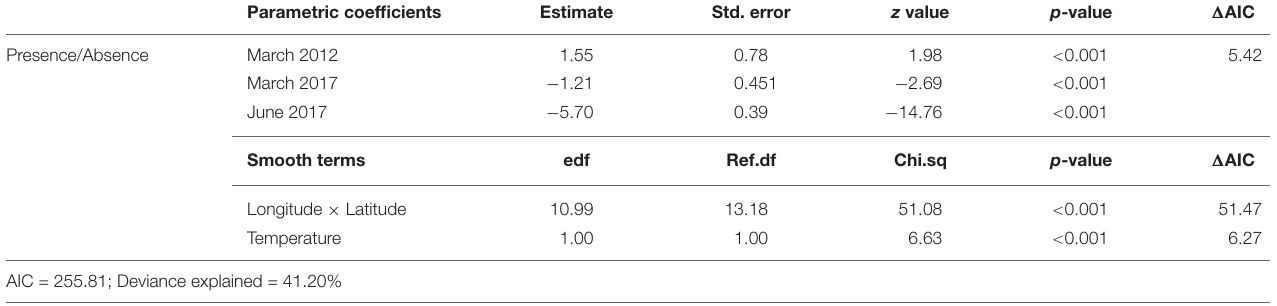
TABLE 2 | Parameter estimates of the best presence/absence (P/A) and abundance models. Parametric coefficients Estimate Std. error